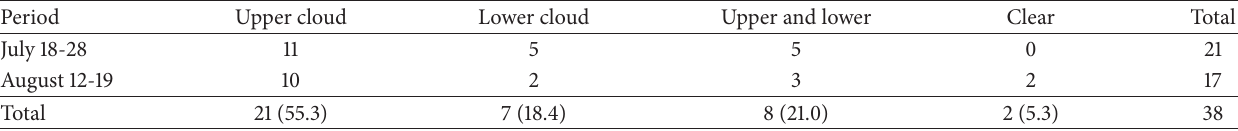
Table 1: Classification of a MODIS scene over Sanriku into upper-level cloud, lower-level cloud, mixed (upper and lower) cloud, and clear sky conditions. The lower- and upper-level clouds were defined by the cloud top pressure to be above and below 600 hPa, respectively (an altitude of approximately 4km). Numbers in brackets indicate the percentages (%) of the total number of observations in each